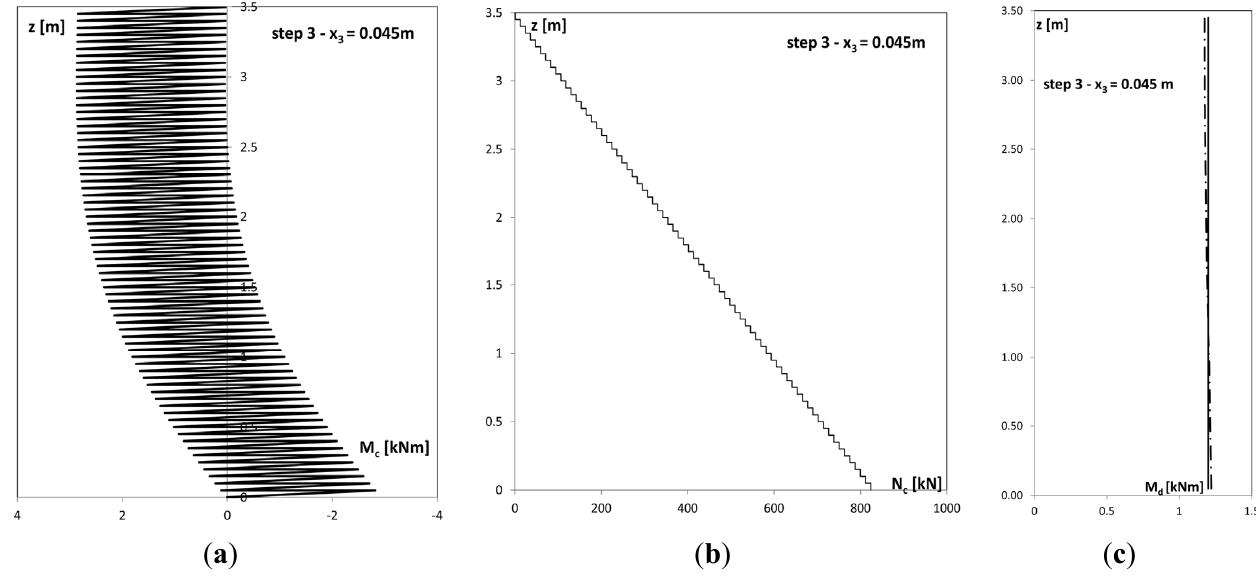
Figure 6. Model A_2: ( a ) Column Bending Moment; ( b ) Axial Force; ( c ) Link Bending